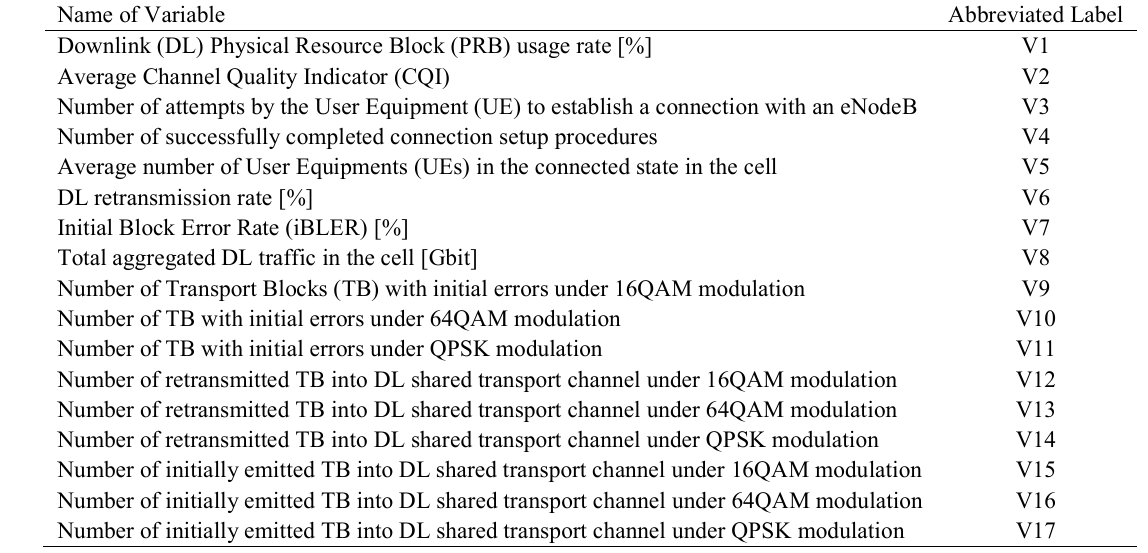
Table 1. Names of independent variables with abbreviated